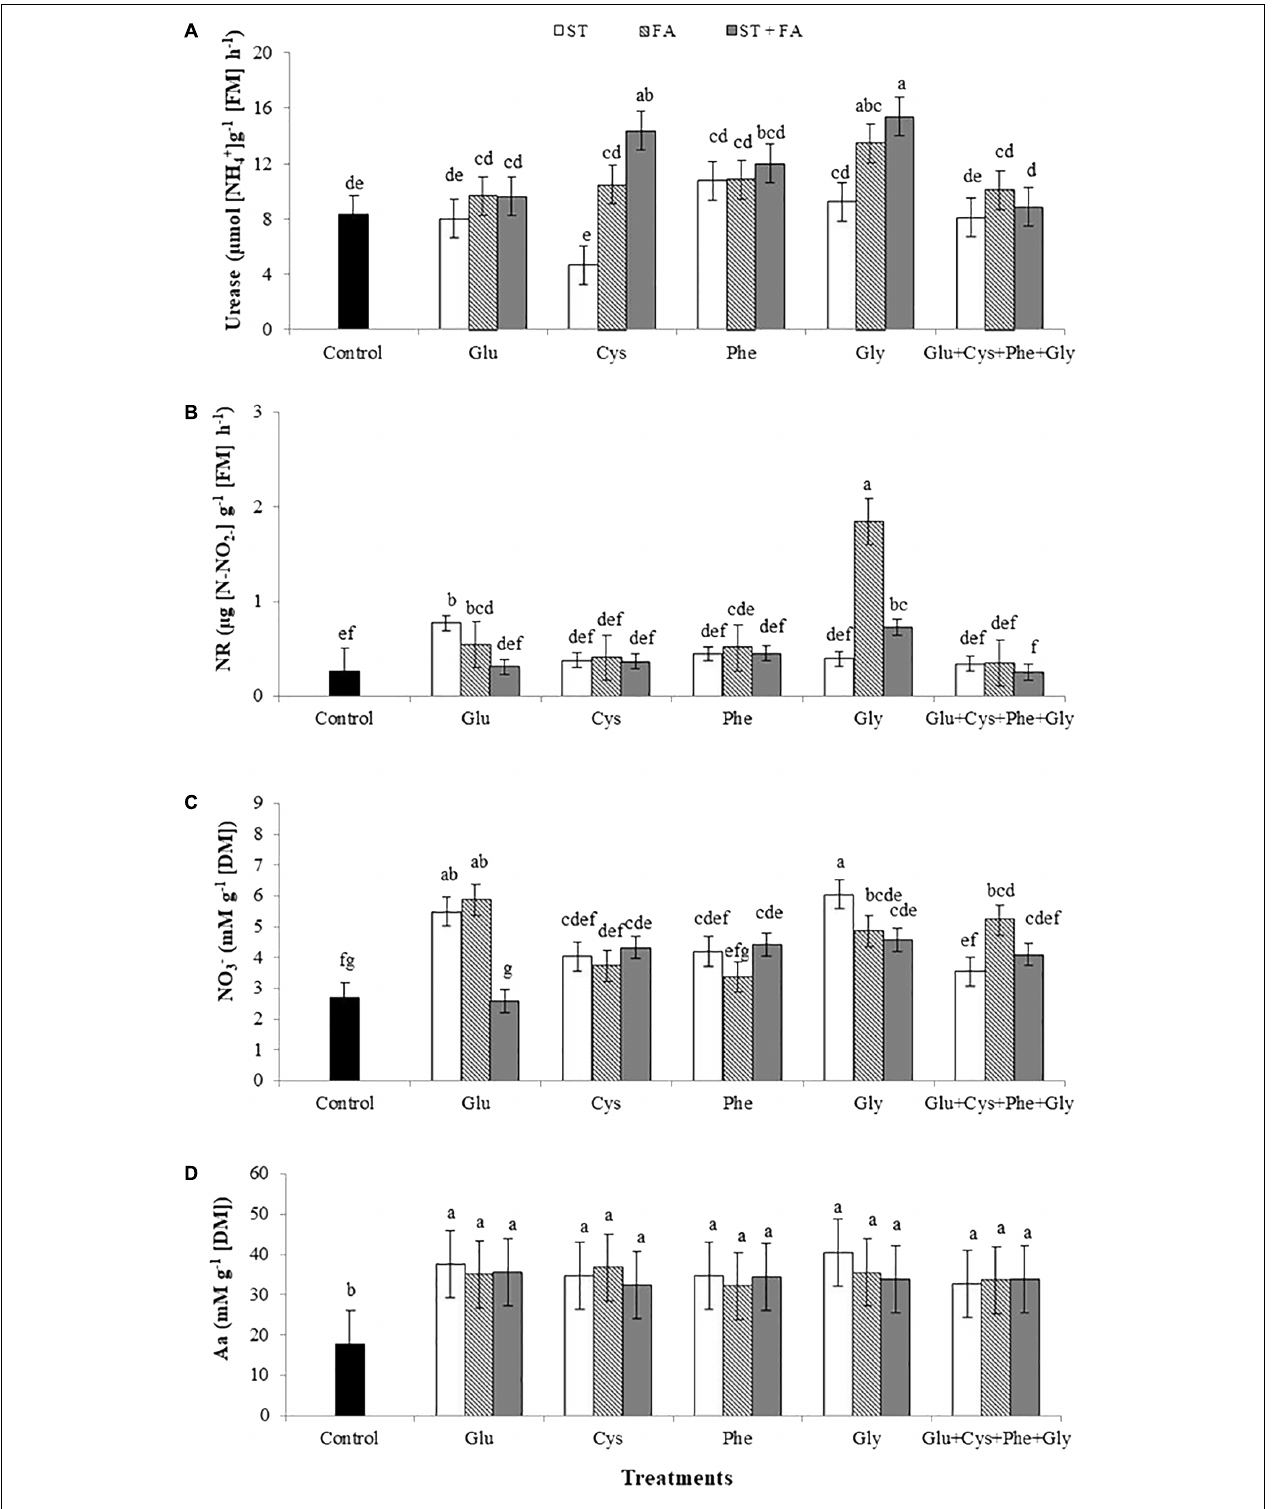
FIGURE 3 | Effects of use of glutamate (Glu), cysteine (Cys), phenylalanine (Phe), glycine (Gly) and all these amino acids in association (Glu+Cys+Phe+Gly), as a function of seed treatment (ST) and/or foliar application (FA), on the soybean leaf urease activity (A) , nitrate reductase activity (NR, B ), nitrate (NO 3 − , C ) and total amino acid (Aa, D ) at the V 6 stage. Field experiment. Season 2014/2015. Means followed by the same letters do not differ significantly from each other, using the Duncan test at 5% significance.